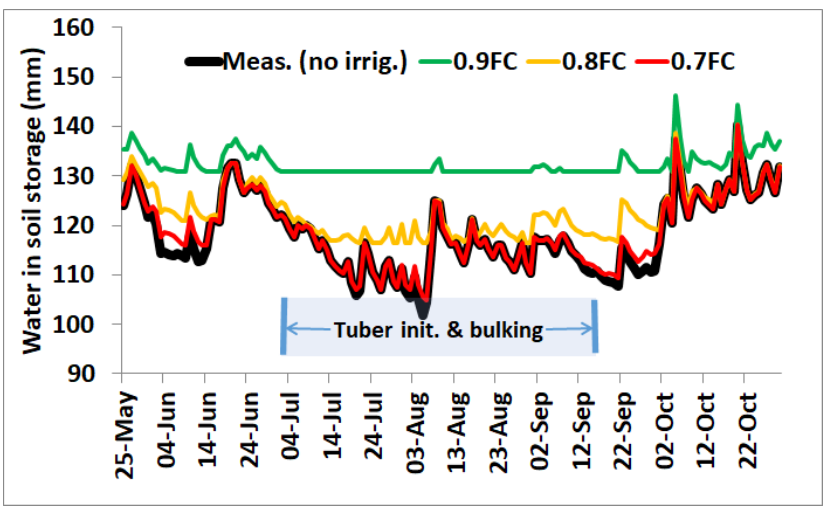
Figure 6. Multi-year daily averages of soil water storage for the potato GS under no irrigation (i.e., Meas. no irrig.) and three supplemental irrigation scenarios.